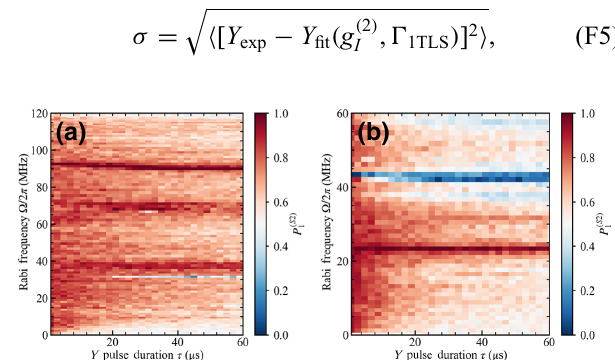
FIG. 10. (a) Dependence of the Rabi frequency on the qubit drive amplitude at the optimal point (cid:5) ≈ 0.5 (cid:5) 0 . The black dashed line corresponds to a linear function plot, added to guide the eye. (b) Dependence of the Rabi frequency on the applied magnetic flux for a fixed qubit drive amplitude.